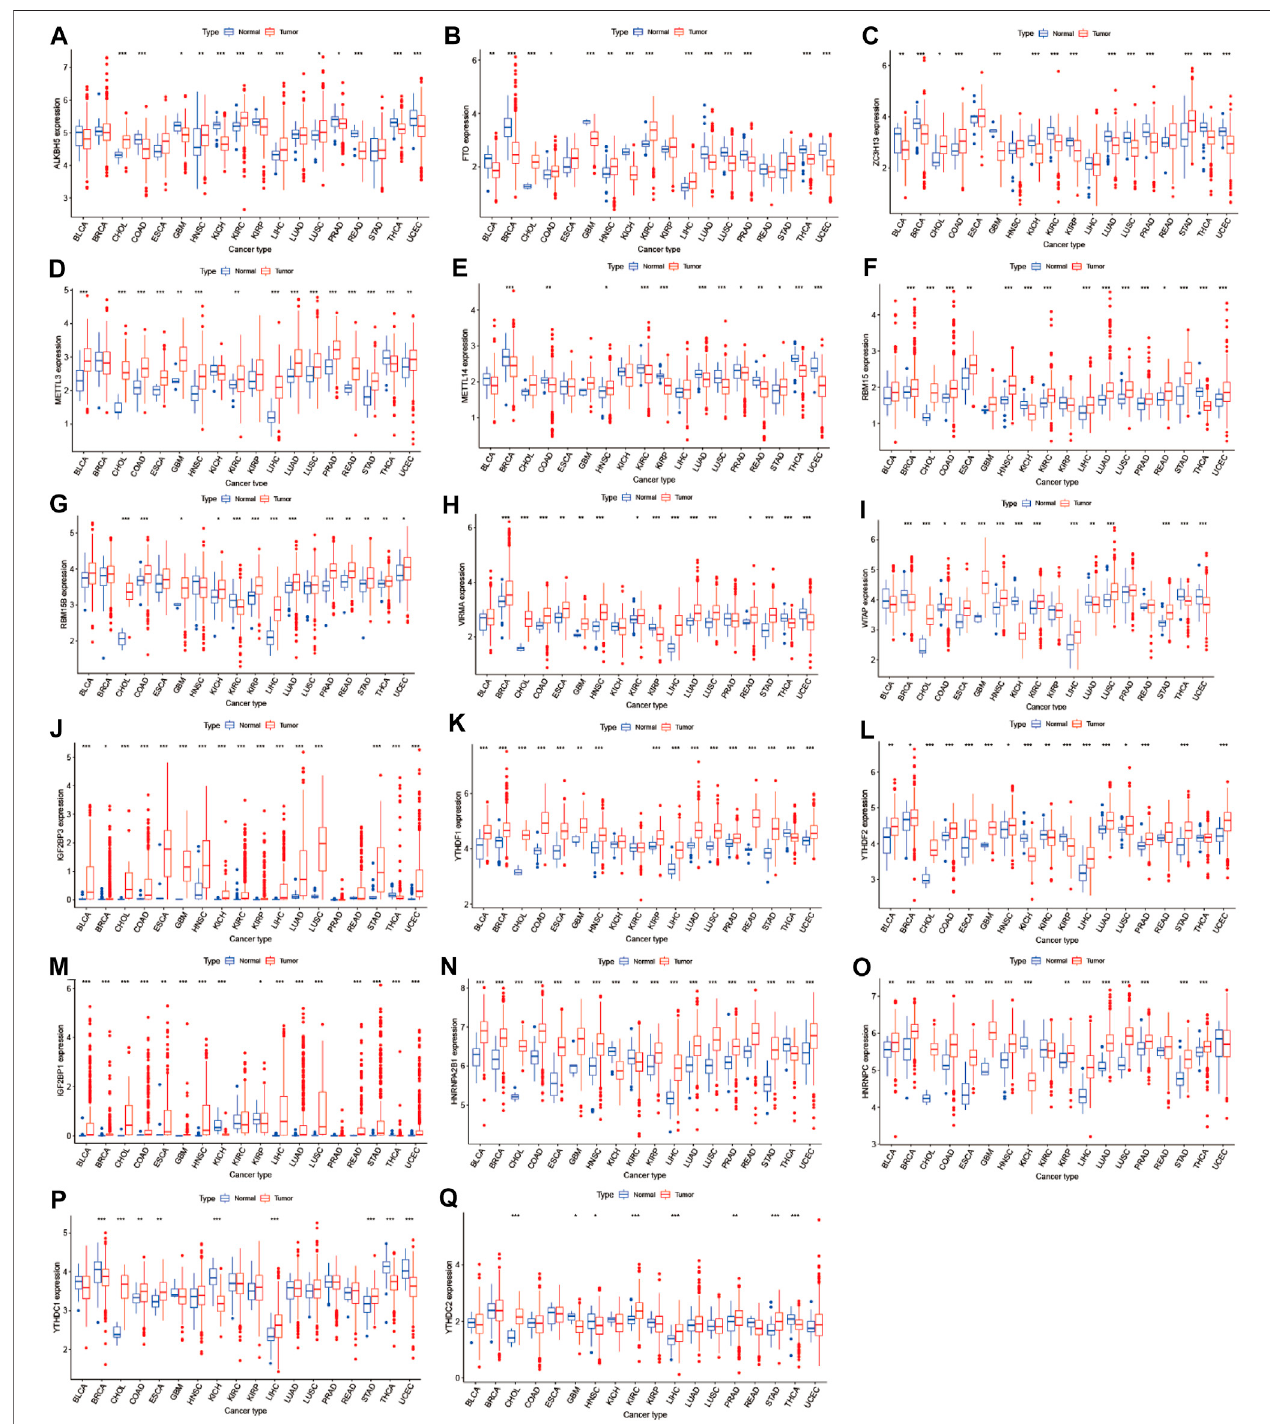
FIGURE 1| Boxplot of m6A regulators differential expression between cancer and adjacentnormal tissues. The blue boxplots indicate the normal tissues. The red boxplots indicate the cancer tissues.